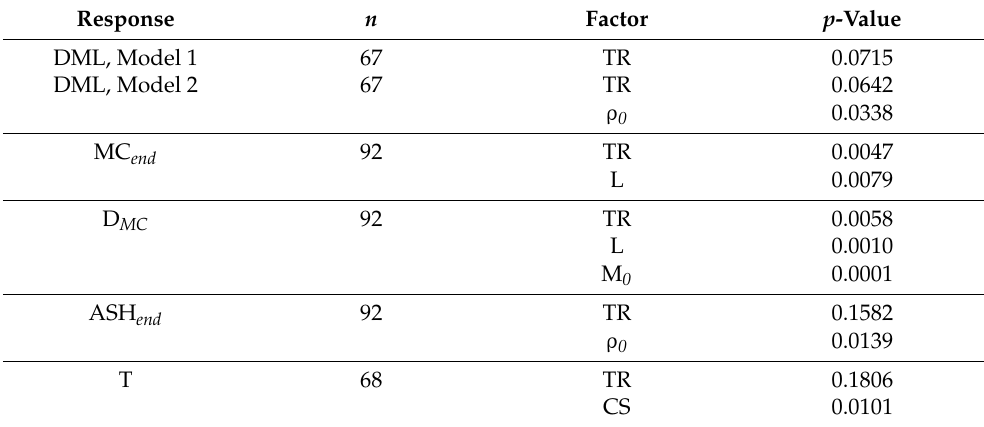
Table 3. The basic facts of the constructed mixed models: the response variables (Response), the number of observations used in the analyses ( n ), the explanatory/fixed factors (Factor), and their statistical significance levels ( p